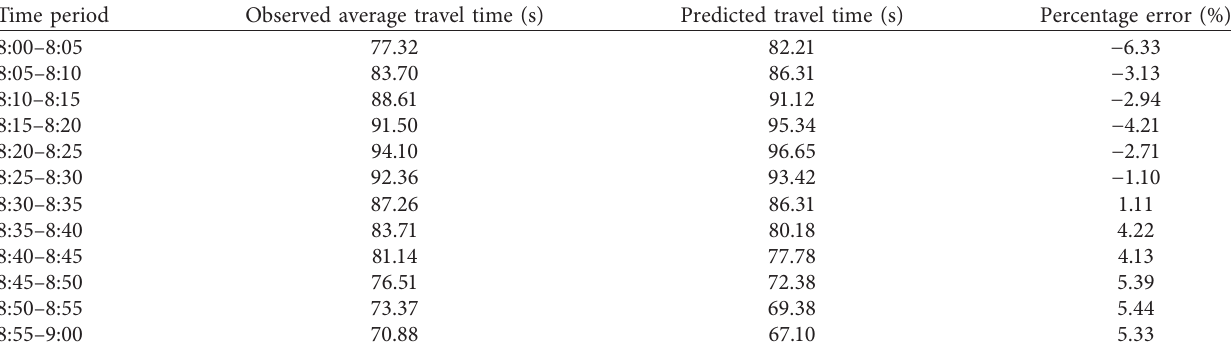
Table 12: Comparison of the observed average travel time and the predicted travel time calculated from applying the calibrated impedance function on Jianshe